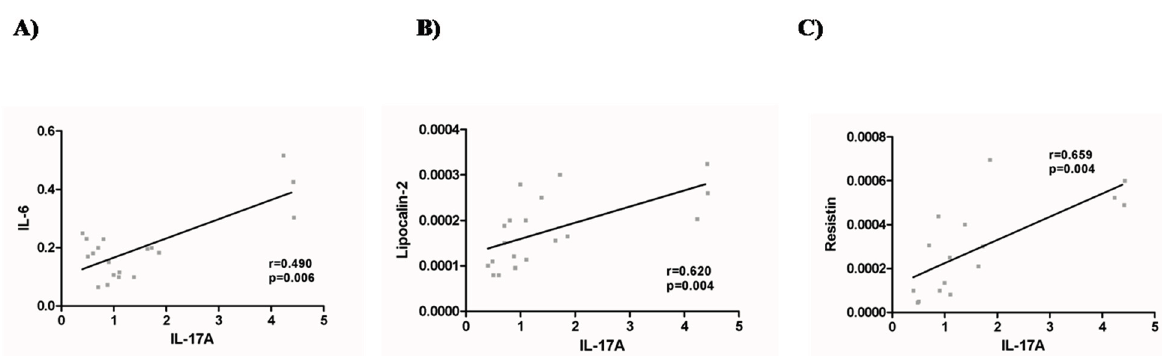
Figure 2. Correlation between mRNA expression of IL-17A and IL-6 ( A ), lipocalin-2 ( B ) and resistin ( C ) in visceral adipose tissue of morbidly obese women. The strength of association between variables was calculated using Spearman’s r correlation test. p <